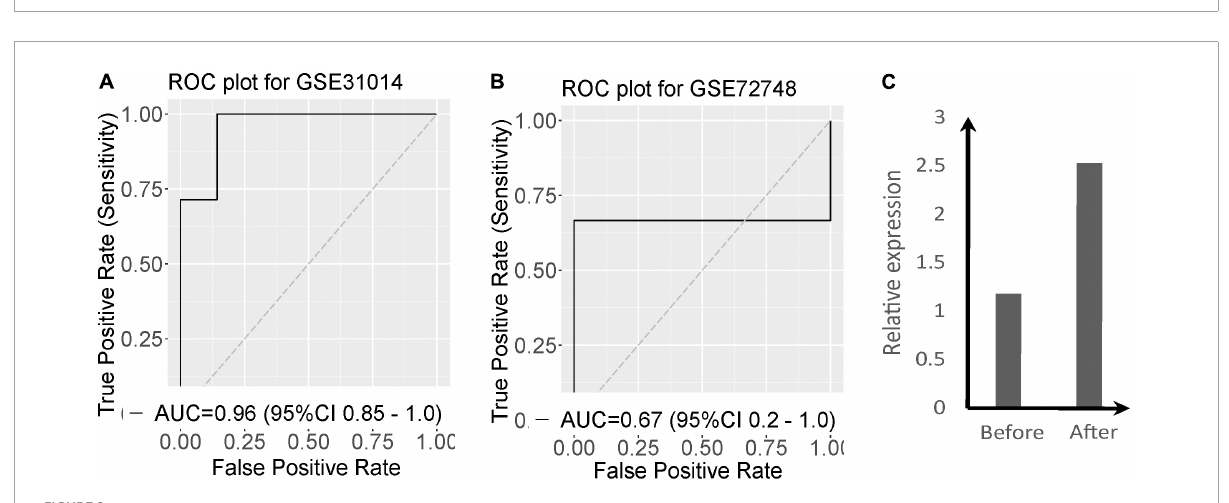
FIGURE2 Validation of the two-gene signature in two datasets of GBS. (A) ROC curves and AUCs of the two-gene signature classification in GSE31014; (B) ROC curves and AUCs of the two-gene signature classification in GSE72748; (C) The expression of PTGDS of GBS patients before and after supportive